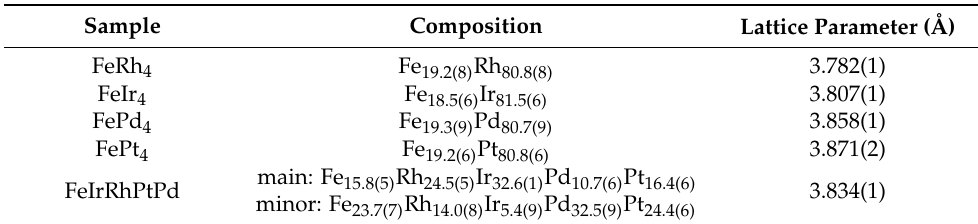
Table 1. Chemical compositions determined by energy-dispersive X-ray spectroscopy and lattice parameters of the prepared